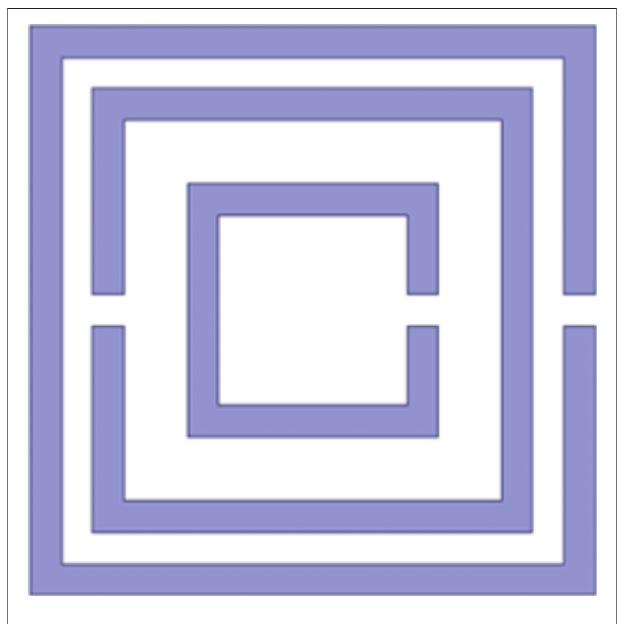
FIGURE 4 | Split ring resonator.